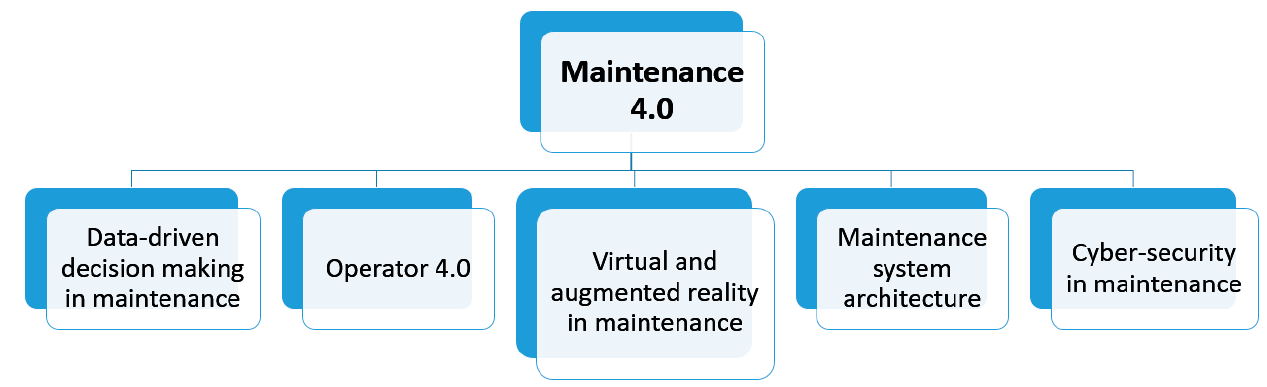
Figure 23. Main issues addressed in the context of the Maintenance 4.0 concept.